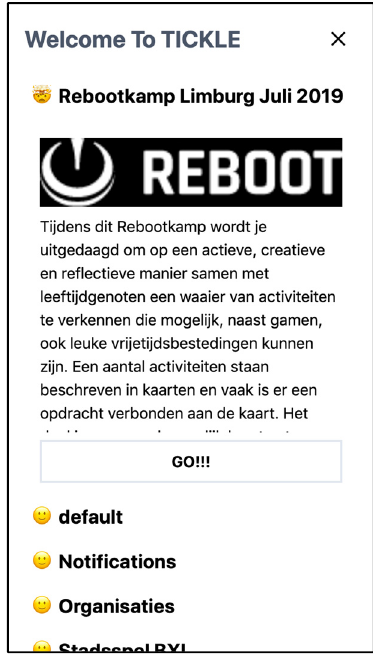
Figure 8. Start screen for a user who has access to multiple card environments.